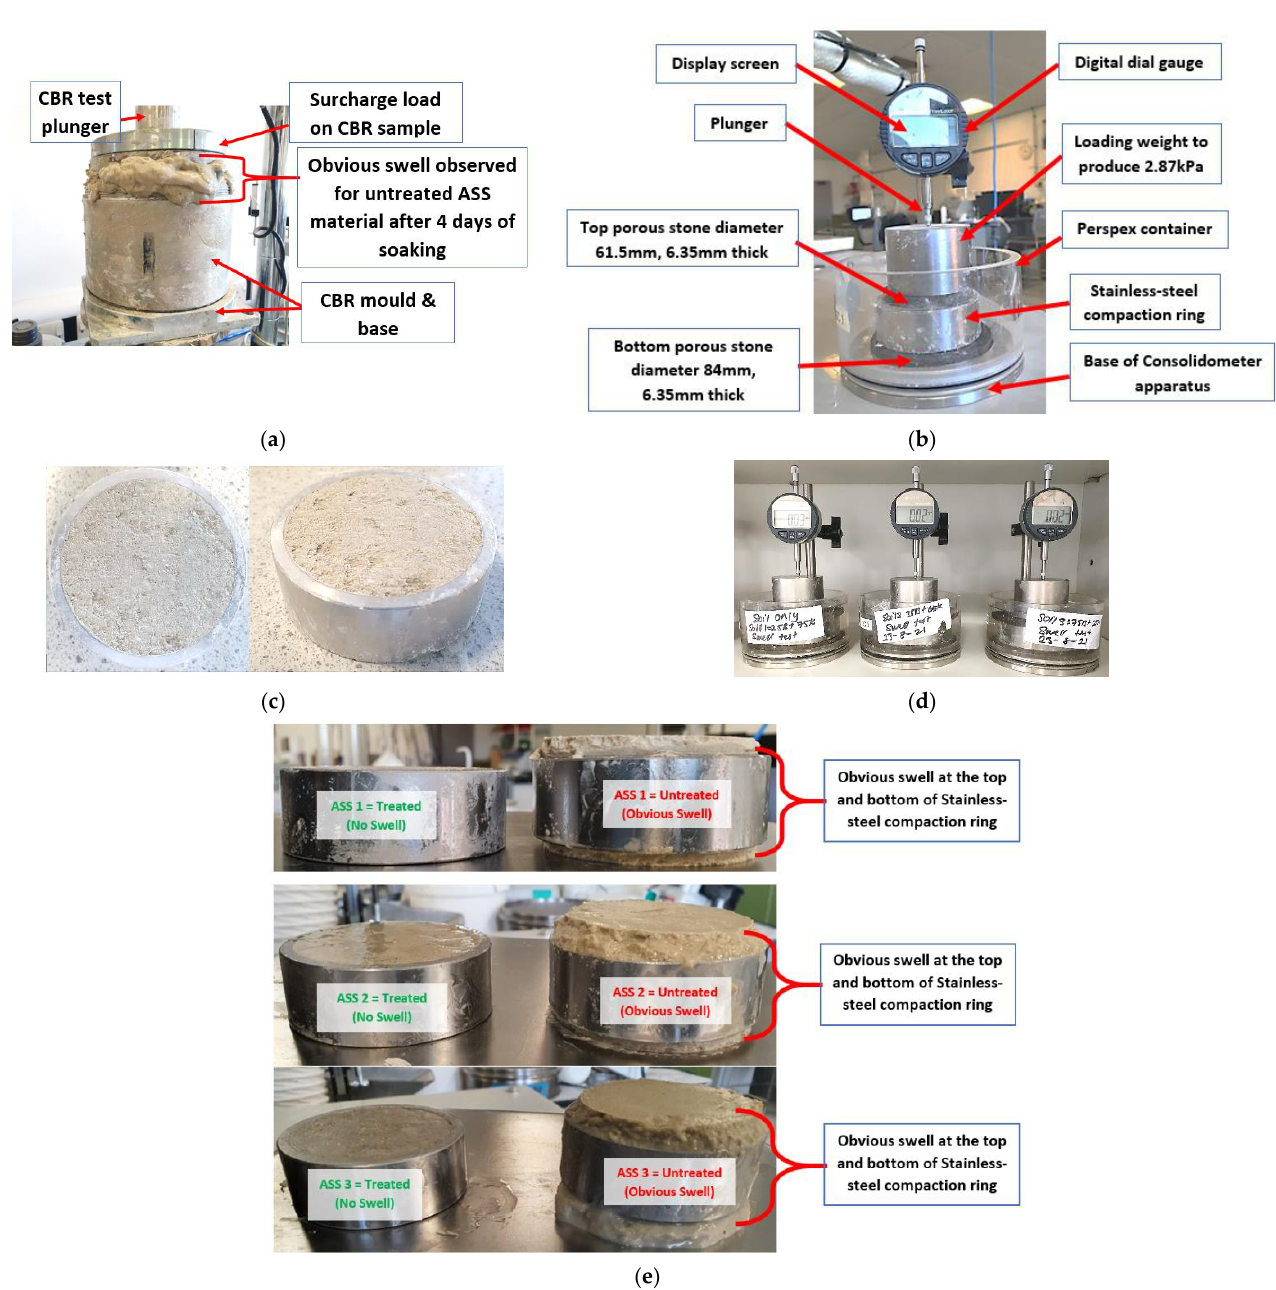
Figure 6. ( a ) Swell observed after soaking CBR untreated ASS samples; ( b ) consolidometer appa- ratus used in this study; ( c ) compacted swell samples in stainless-steel compaction ring; ( d ) swell set-up for treated and untreated ASS materials; ( e ) treated and untreated ASS samples after the swell test